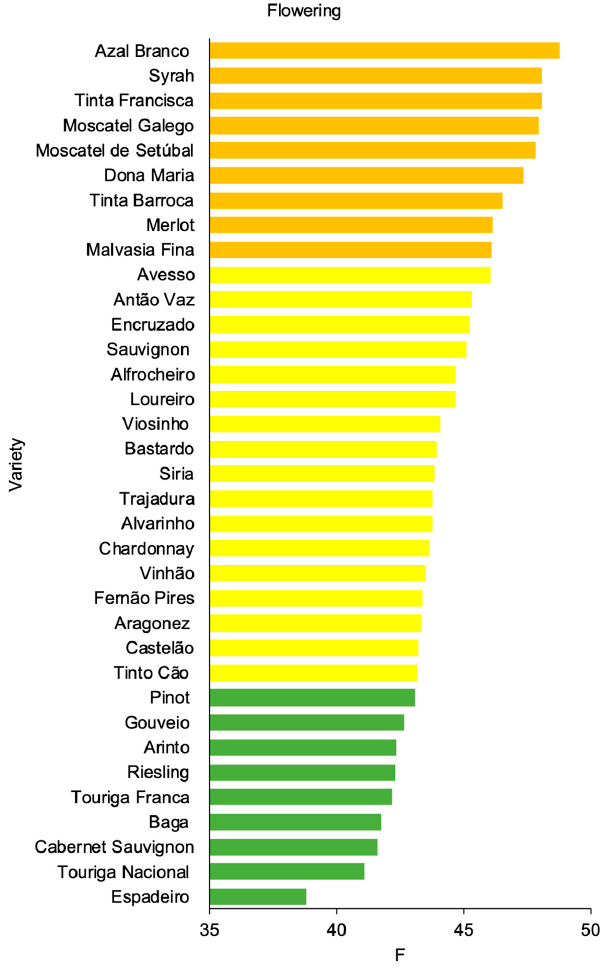
Figure 7. Ranking of the F measure for flowering by grapevine variety in the Lisboa wine region. Only models with EF ≥ 0.5 are shown. 383